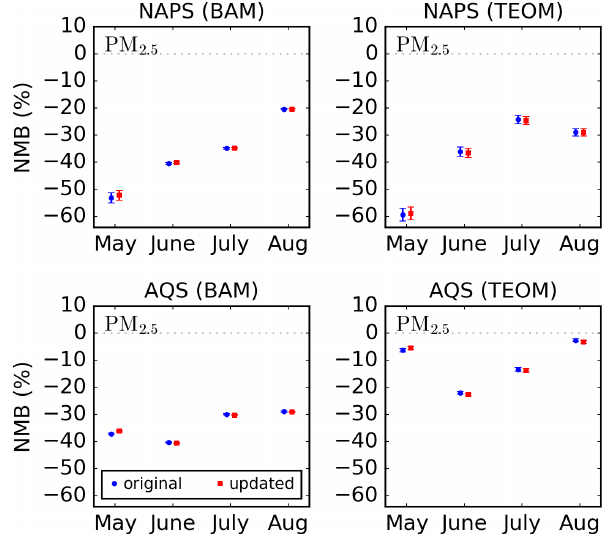
Figure 14. Normalized mean biases between GEM-MACH total PM 2 . 5 surface fields and BAM and TEOM observations from the NAPS network and observations reported to the AQS for May to August 2016. In the legend, “original” and “updated” indicate the ammonia emissions used in GEM-MACH. Error bars correspond to the standard